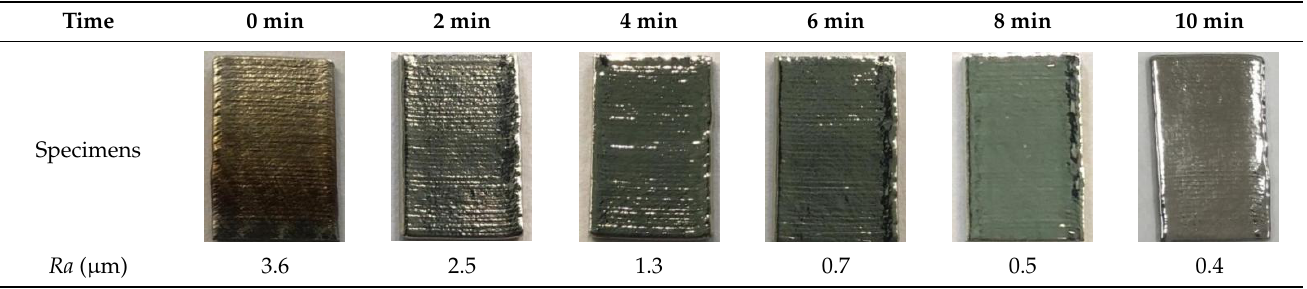
Table 6. Specimen images and surface roughness at different time points.